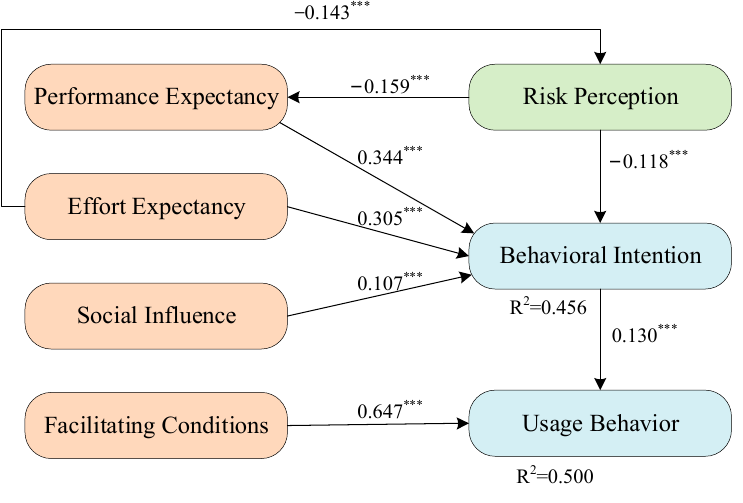
Figure 2. Path coefficients. Note: *** represents p <